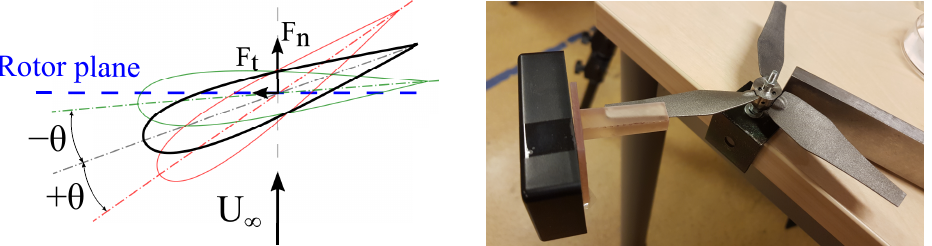
Figure 4. Pitch angle definition ( left ) and setting setup ( right ).